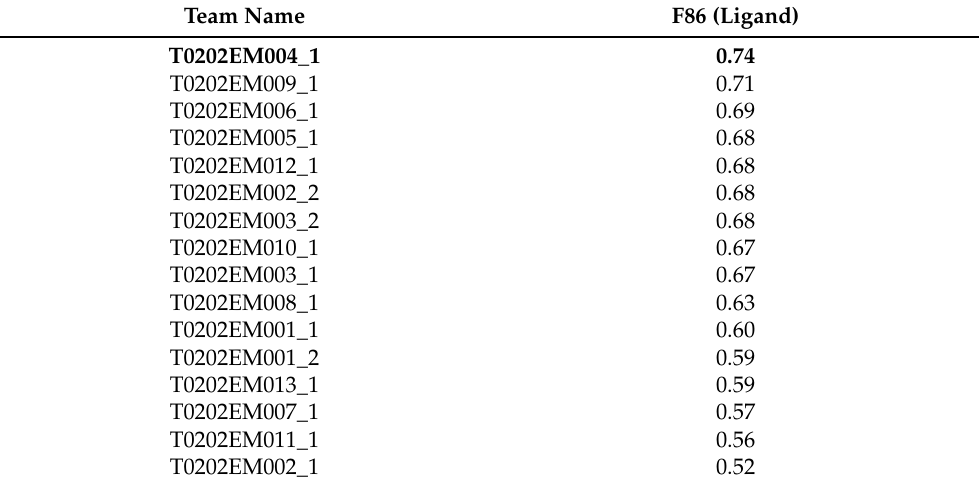
Table 5. Evaluation of Target 202: SARS-CoV-2 RNA-dependent RNA polymerase on Q-score for all the models submitted to the 2021 Ligand Model